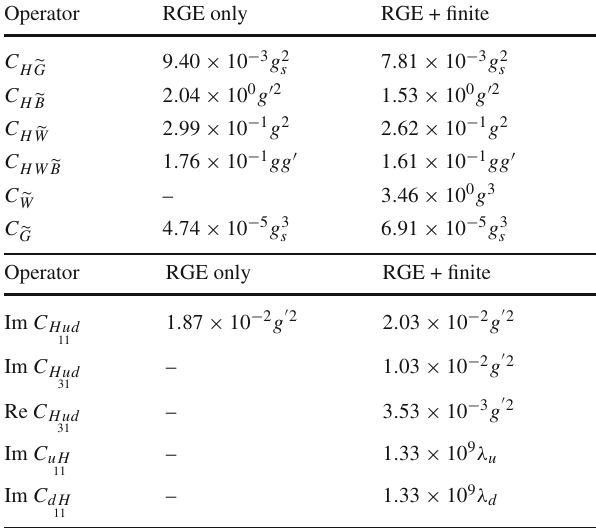
Table 7 Upper bounds on the Wilson coefficients of the bosonic oper- ators on the left and the ψ ¯ ψ H 2 D and ψ 2 H 3 type operators on the right assuming (cid:2) = 5 TeV and no further assumptions. The ‘RGE + finite’ column for C Hud also includes the tree level 11